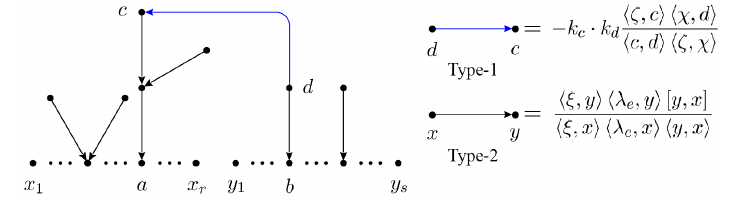
Figure 1 . A typical spanning forest for double-trace ( g − , g − ) -amplitude, which includes a bridge connecting two traces by a type-1 edge and several type-2